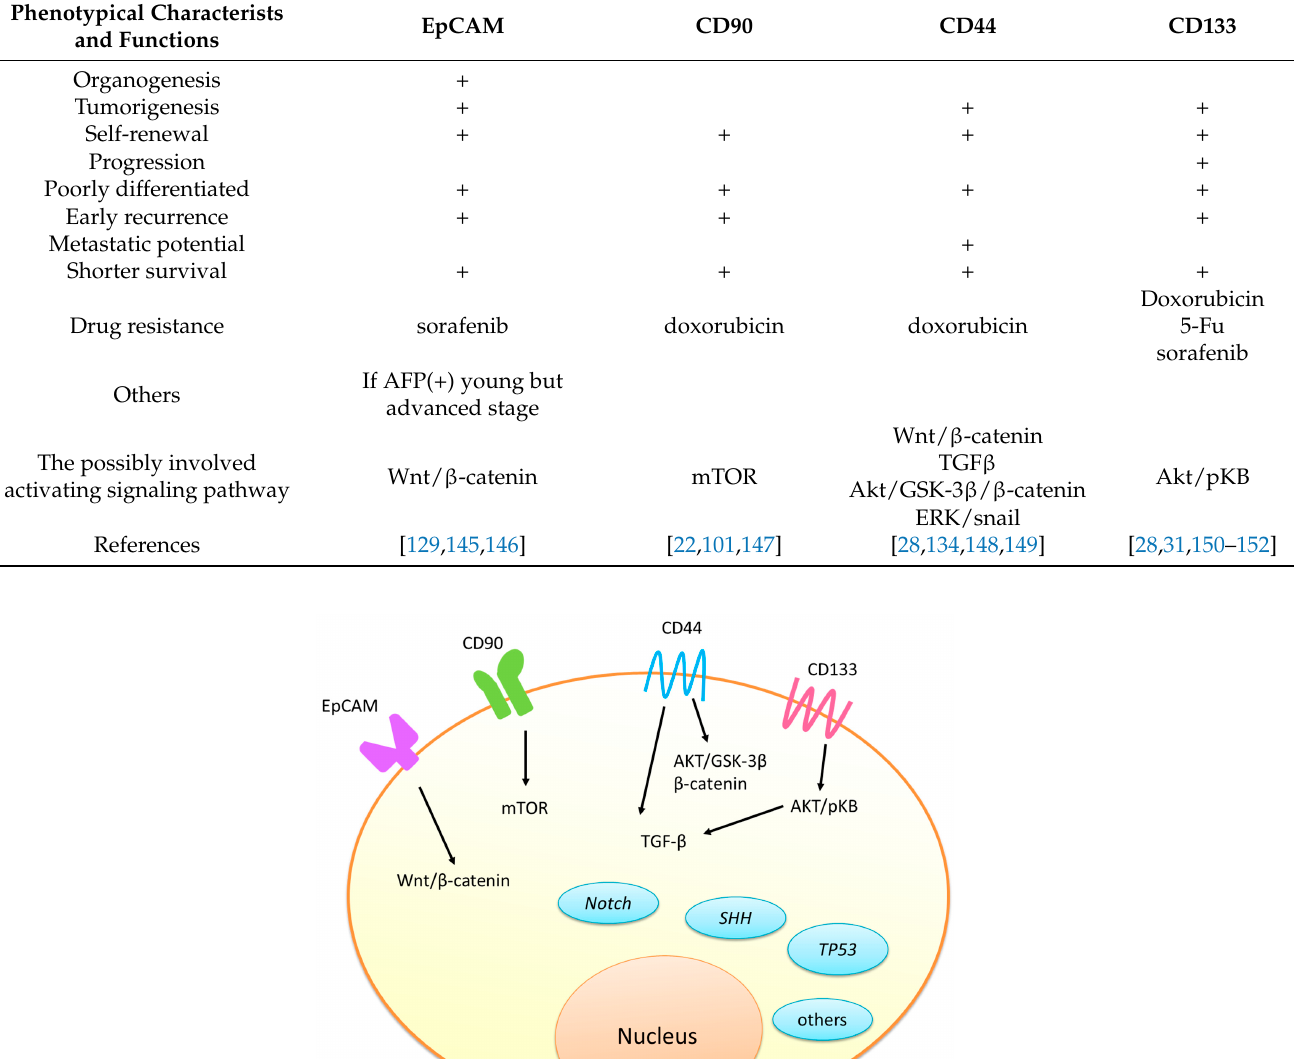
Table 1. Phenotypical characteristics and functions of the main cancer stem cell markers of hepatocel- lular carcinoma.